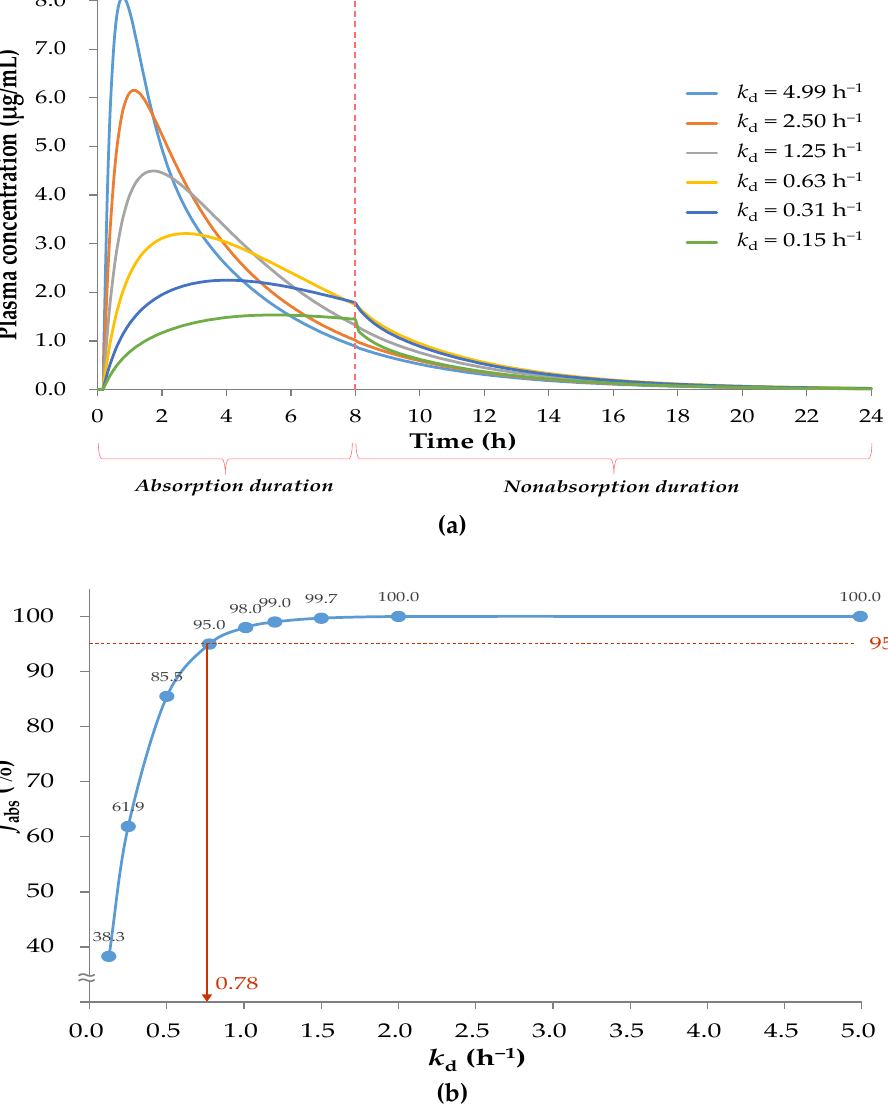
have the same daily dose of 1459 mg. The pharmacokinetic efficacy indexes (i.e., C max ,